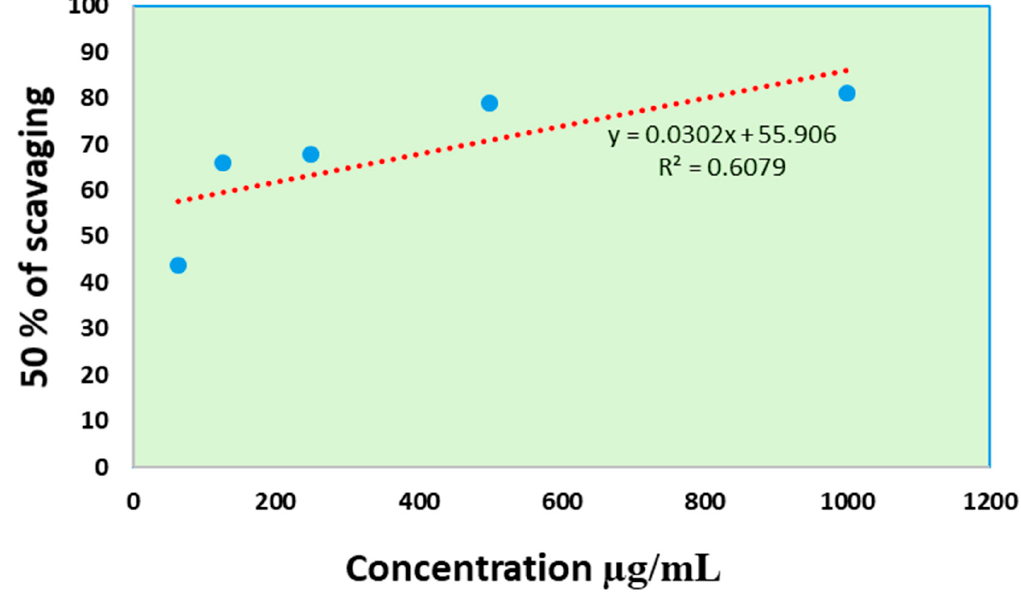
Figure 8. The scavenging percentage of 50% inhibition of DPPH (IC 50 ) of the Chorisia speciosa extract.